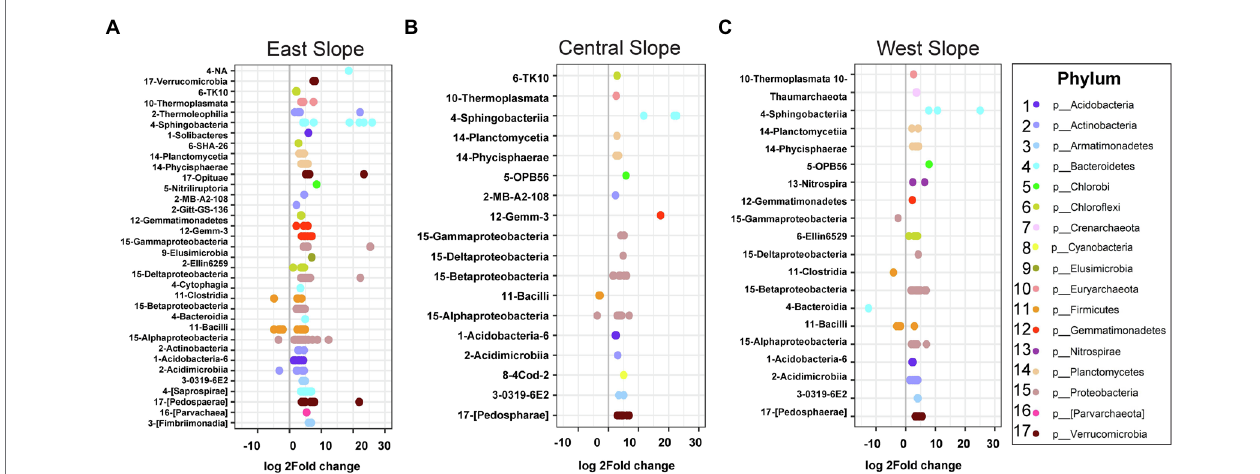
FIGURE 5 | Microbial community membership shifted consistently with precipitation across slopes. Nested differentially abundant OTUs in (A) East, (B) Central, and (C) West hillslopes with differential enrichment of classes. In the figures, log2fold change greater than zero indicates enriched classes post-precipitation, while values less than zero indicate reductions relative to